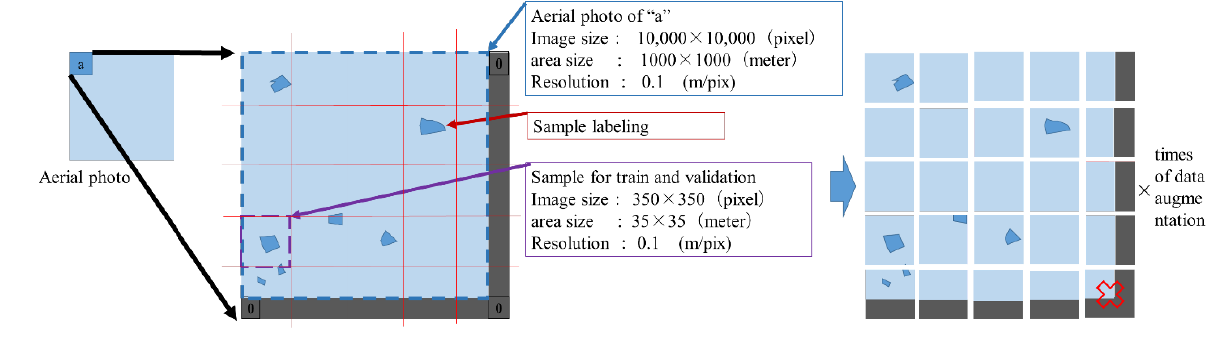
Figure 4. Schematic of labeling and cropping on the aerial photo.